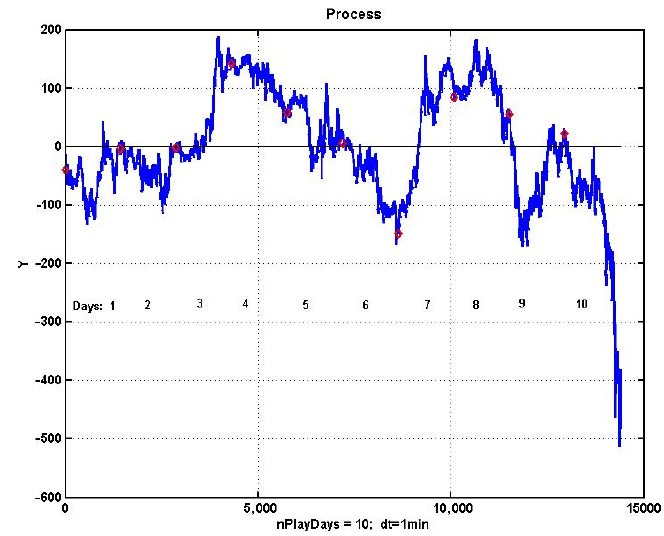
Figure 6. Dynamics of quotations during the indicated 10 days, corresponding to the performance of the CSF strategy in Figure 5.